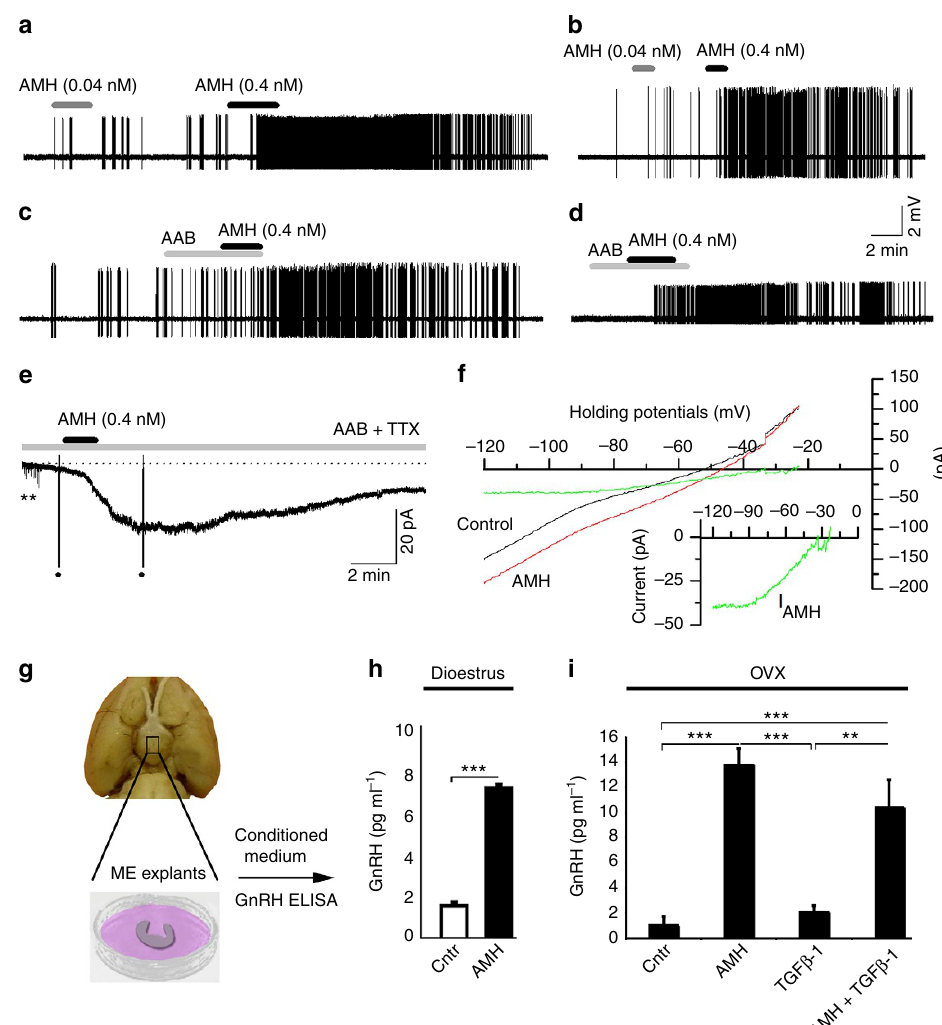
Figure 4 | AMH increases GnRH neuron firing and hormone secretion. ( a , b ) Cell-attached voltage recordings of GnRH neurons from GnRH::GFP male mice stimulated with AMH. ( c , d ) Cell-attached voltage recordings of GnRH neurons from GnRH::GFP diestrous mice. AAB (AP5, CNQX and GABAzin) application shows that AMH excitation of GnRH neurons is not dependent upon amino-acid transmission. ( e ) Whole-cell current recording of a GnRH neuron in the presence of AAB and tetrodotoxin (TTX). **Spontaneous synaptic currents blocked by AAB þ TTX. Dots indicate truncated currents induced by the ramp voltage protocol. ( f ) Current–voltage plots before (black) and during AMH response (AMH, red). The ‘AMH current’ (I AMH , green) is obtained by the subtraction of control from AMH current at ramp potentials ( (cid:2) 120 to (cid:2) 20mV for 1.5s). AMH current with a reversal potential around (cid:2) 30mV is